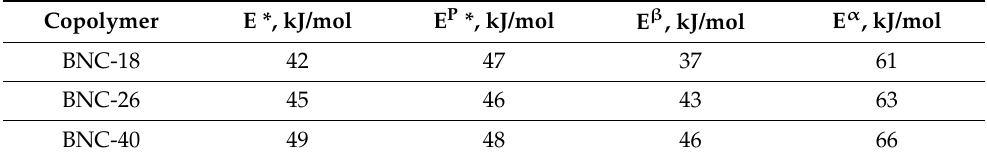
Figure 7. Relaxation dependencies γ for BNC-26 in coordinates of Equation (4). Surfaces are formed on the: 1—aluminium, and 2—PTFE. Table 4. Relaxation activation energies γ and γ p and activation energies, α - and β -transitions of copolymers [25].